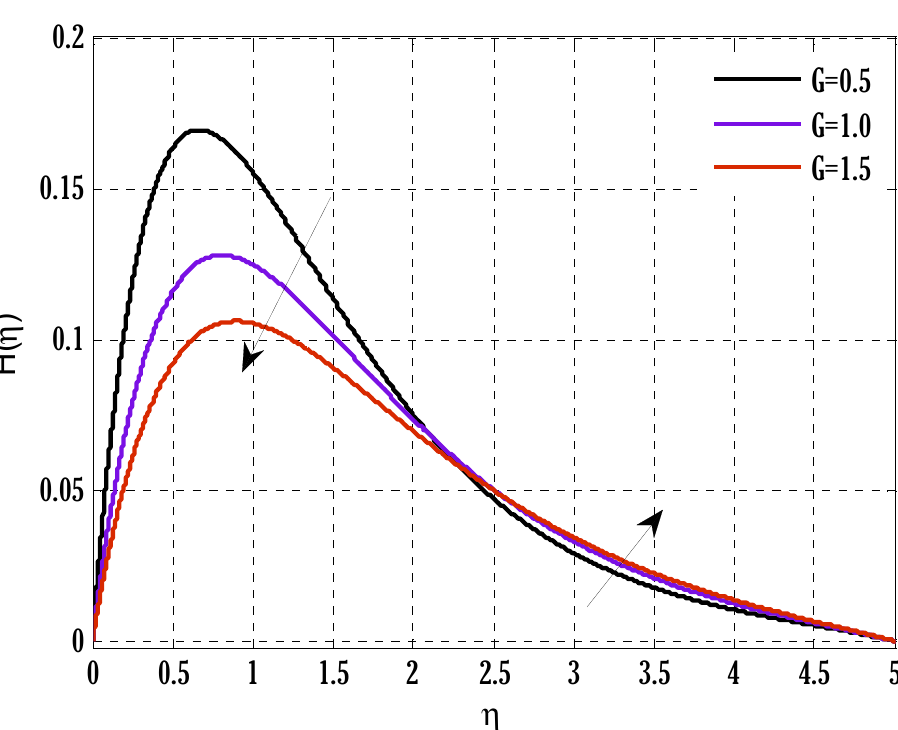
Figure 9. Effect of microrotation parameter on angular velocity using K b = 0.01, λ = 0.1, F r = 0.1, and N = 3040.